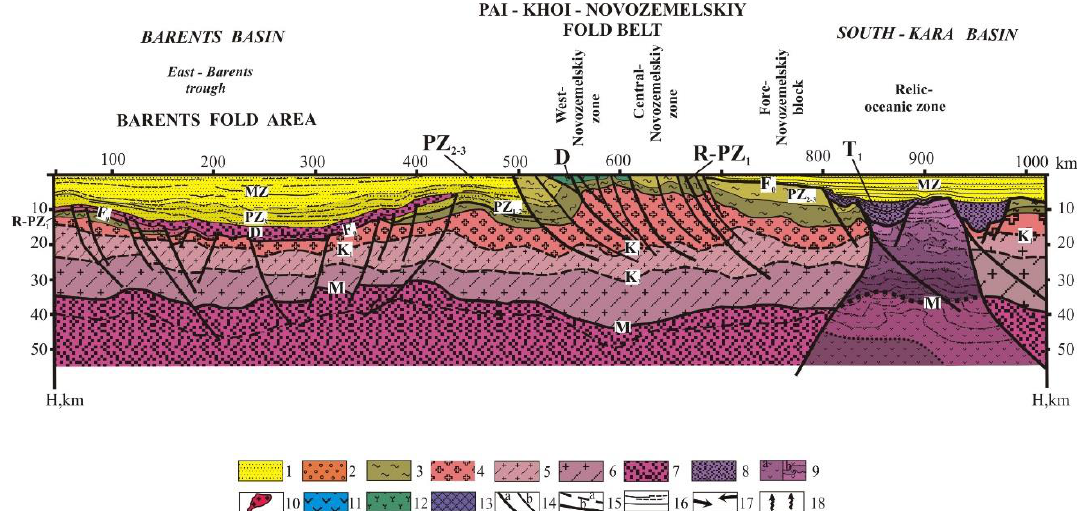
Figure 5. Section of the Earth's crust along the AR-2 geo-traverse. Compiled using materials from State enterprise "Sevmorgeo" [7]. See Figure 2 for legend. Numbers 1–13 are structural and substational units of the lithosphere: 1—weakly deformed sediments of the platform cover; 2—molasses; 3—lithified sediments of the ancient passive margin; 4—granite-gneiss layer; 5—middle crust; 6—lower crust; 7—lithospheric mantle; 8—riftogenic complexes; 9—oceanic type crust, including ifferentiated by the speed of elastic waves; 10—granitoid plutons; 11—island arc complexes; 12—volcanic complexes of active margins; 13—ophiolites; 14—breaking dislocations (a—major, b—minor); 15—boundaries of radial stratification of the Earth’s crust, including a—minor (F0—basement of the platform cover, K1—the basement of the upper crust, K2—the basement of the middle crust); b—the basement of the Earth’s crust (Mohorovichich boundary); 16—sub-horizontal boundaries and lineaments of the seismic section; 17—trends in mutual displacements of segments of the Earth’s crust; 18—trends of heat and mass transfer within the